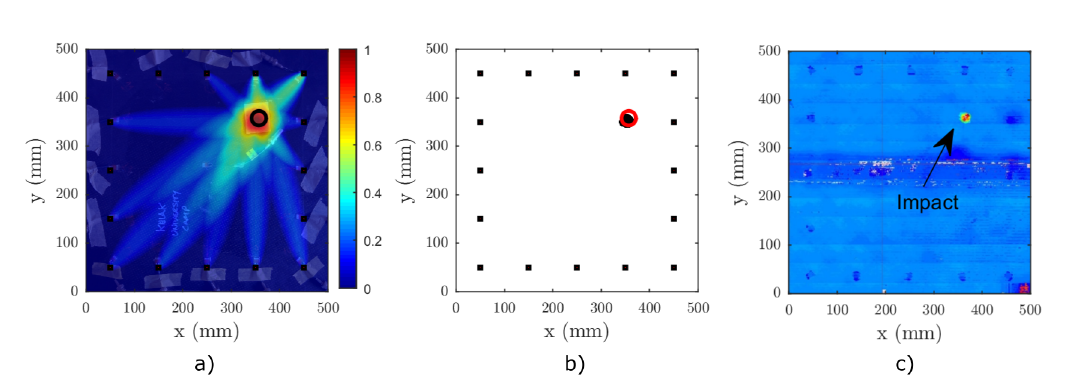
Figure 11. Baseline-dependent RAPID imaging on a CFRP plate, excitation waveform: five-cycle sine burst f = 50kHz, β = 1.015 and t SDC = 0.5 ( a ) damage index P ( x , y ) , ( b ) thresholded binary RAPID image using a threshold level at t P = 0.9max { P ( x , y ) } ( c ) ultrasonic C-scan of the